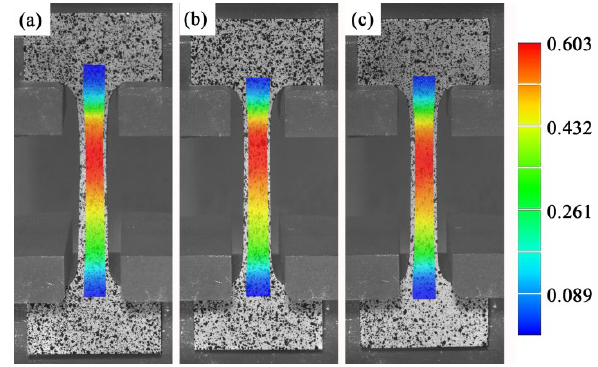
Figure 2. Strain maps for different crosshead speeds: ( a ) 0.9 mm/min; ( b ) 9 mm/min; ( c ) 90 mm/min.